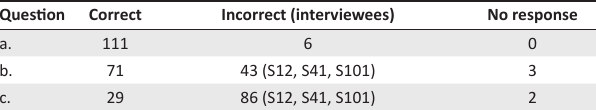
TABLE 3: Summary of responses to Question